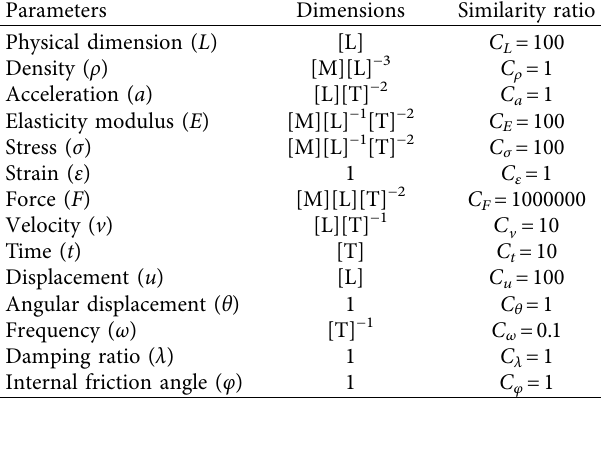
Table 2: Similarity ratios of the shaking table test.